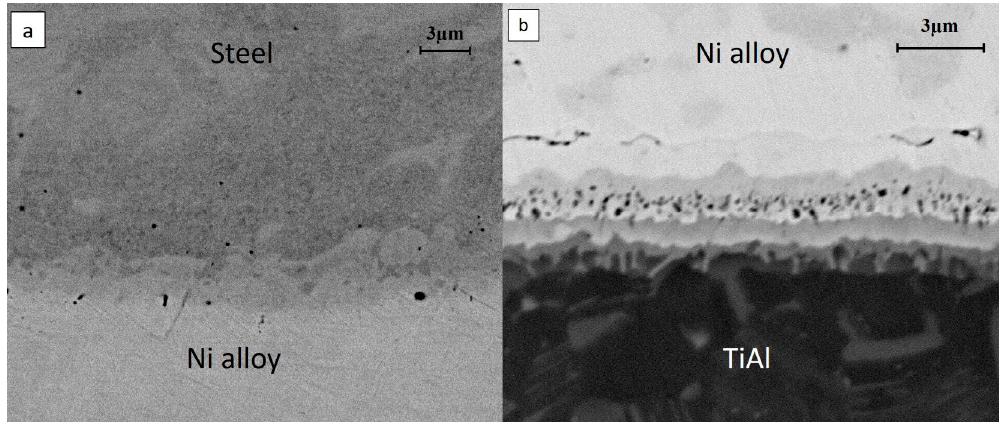
Figure 3. Diffusive interfaces between ( a ) steel and nickel-based material; and ( b ) TiAl and nickel-based material.